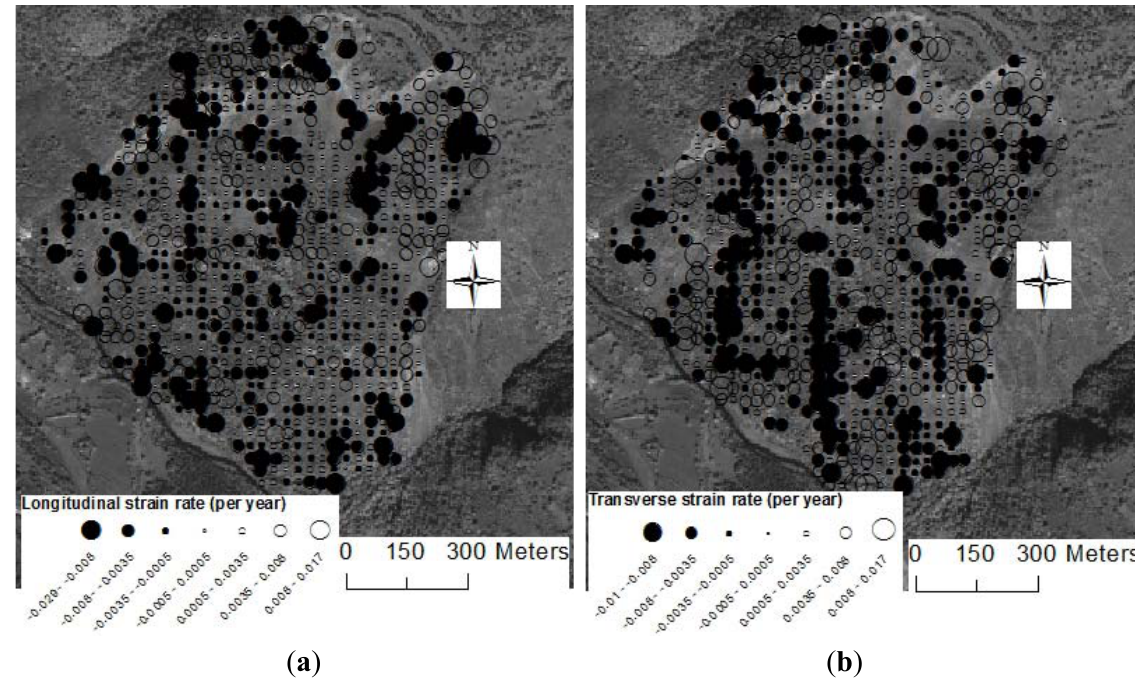
Figure 9. The longitudinal (cid:2013)(cid:4662) rotation rate φ(cid:4662) ( d ) for the La Clapière